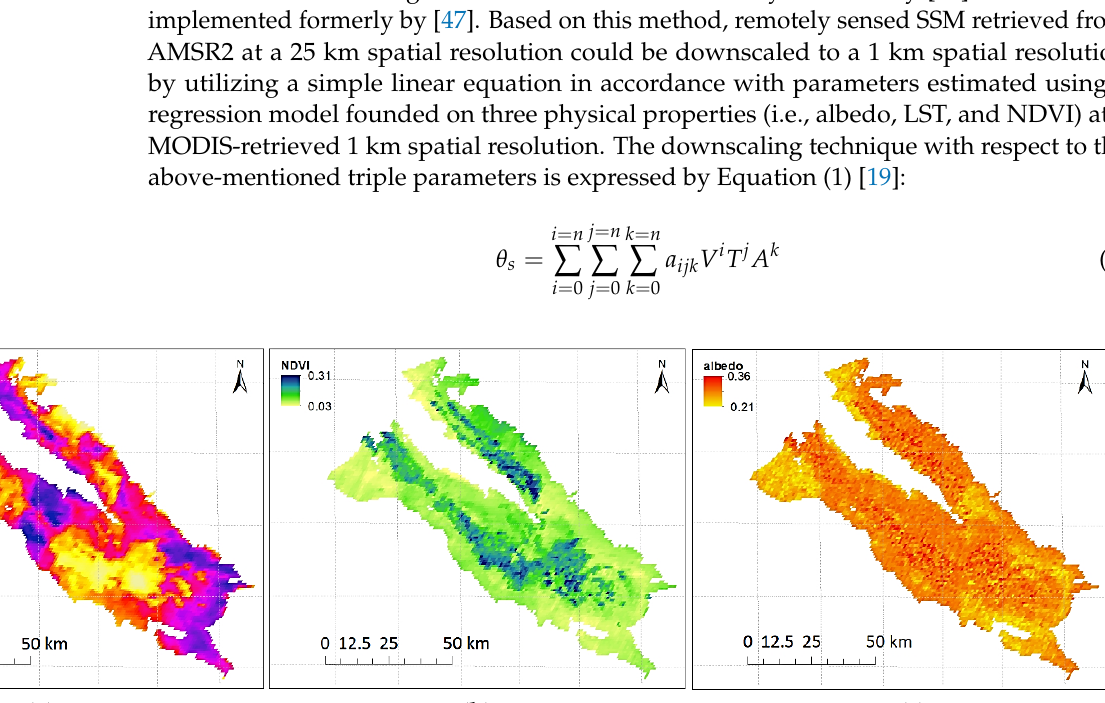
Figure 2. ( a ) Location of stations in Rafsanjan plain, ( b ) REC-P55 SM sensors manufactured by Ansari and Hassanpour [40] installed in study wells at three different depths of 10, 40, and 100 cm, and ( c ) two layers of surface and deep (root zone) soil considered in the SMAR model.